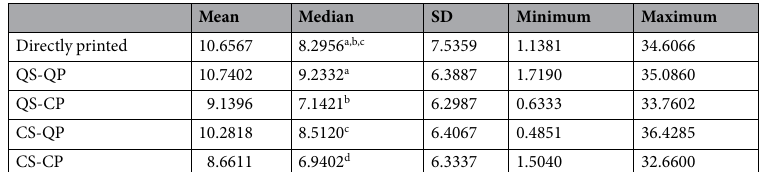
⁎ between the original and the printed colour charts. * SD ab